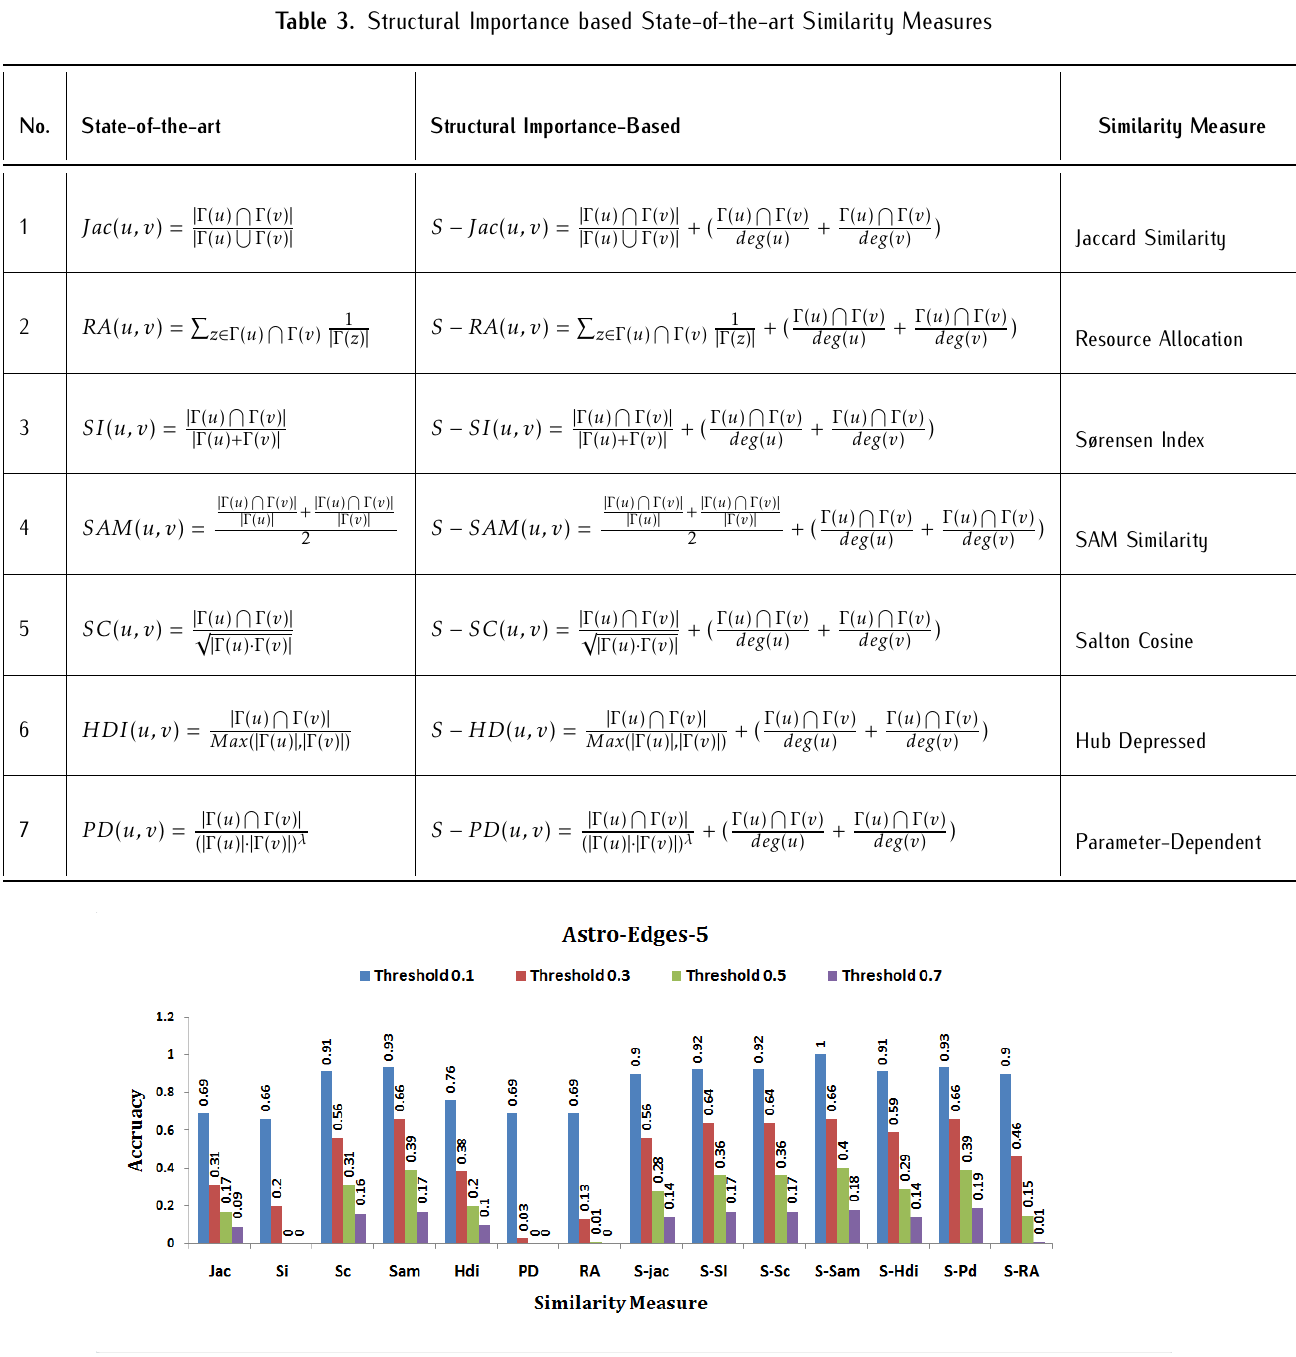
Figure 2. Prediction Results using Astro Dataset with 5%